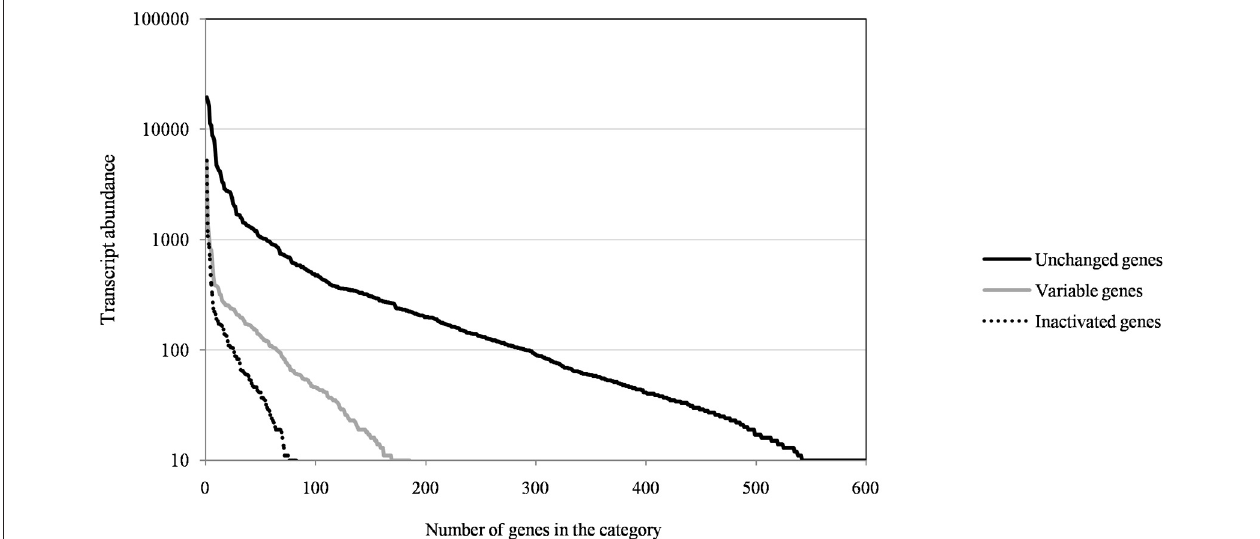
FIGURE A1 | The distribution of transcript abundance of Mimivirus M1 genes for unchanged, variable, and inactivated genes after 150 passages in allopatric laboratory culture on amoebae.